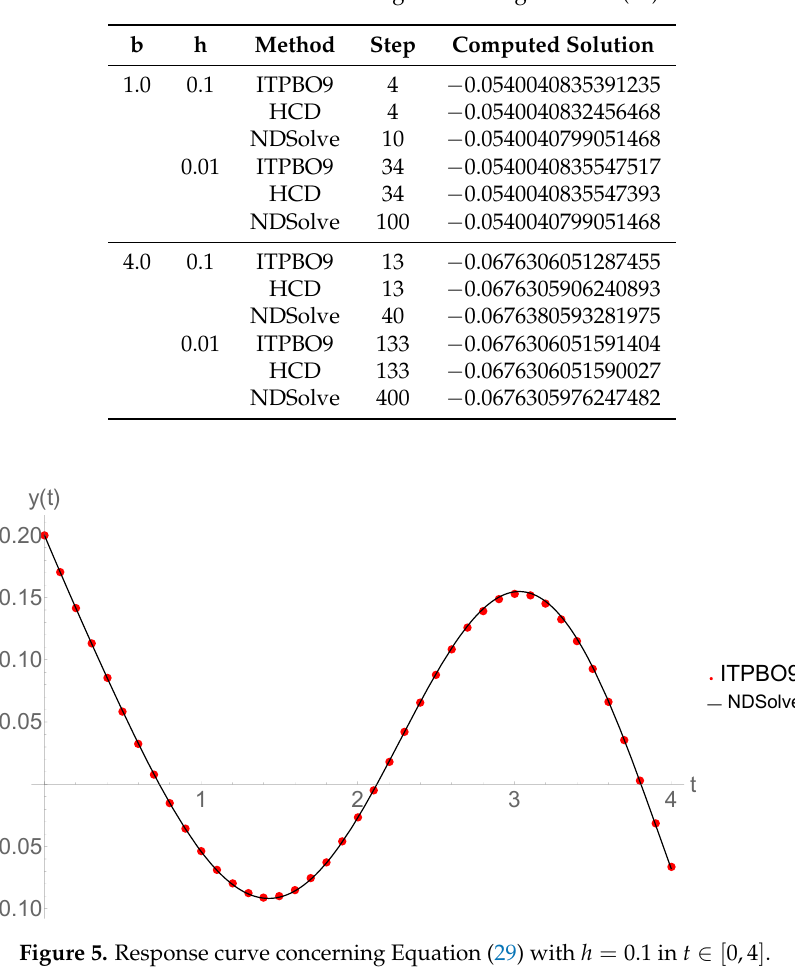
Table 10. Numerical findings for solving Problem (29).